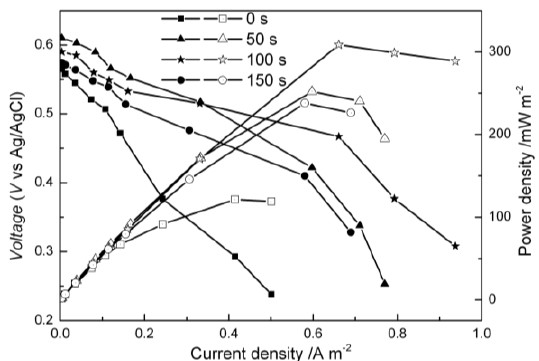
Figure 3. Power densities of four microbial fuel cells (MFCs) with different deposition times.